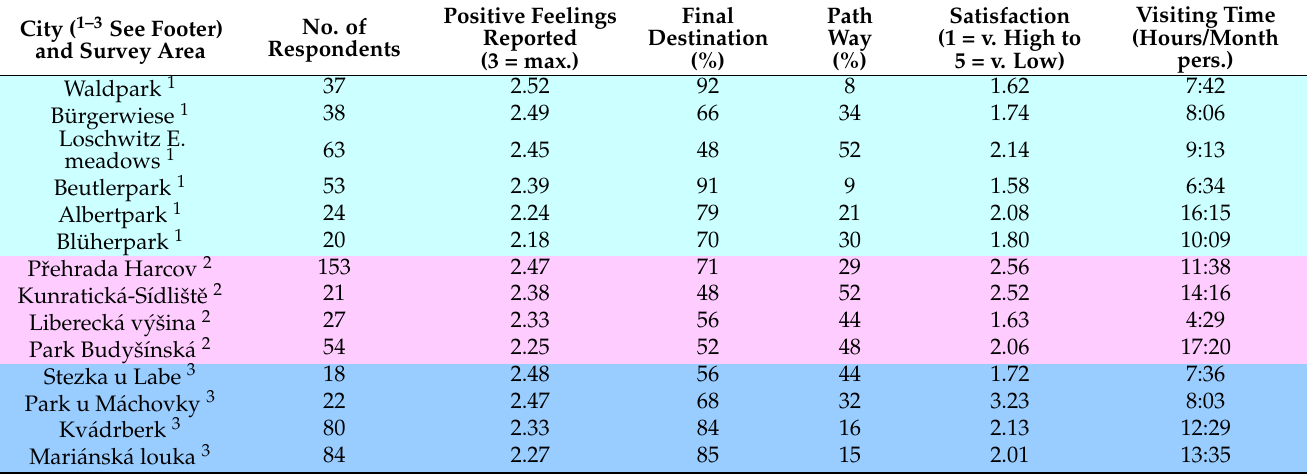
Table 4. Survey findings on urban green areas as final destination vs. pathway, satisfaction level and average duration of visits per month (green spaces in each city ranked by positive feelings of